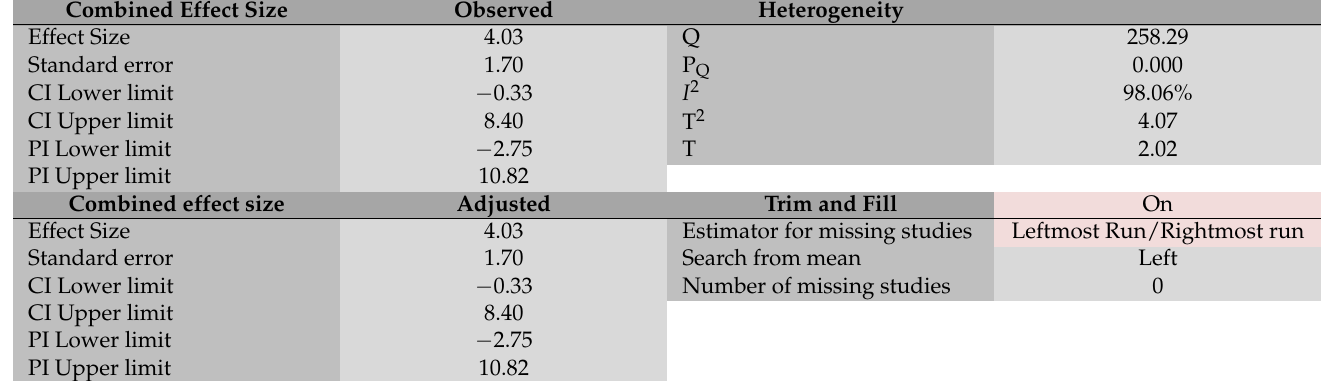
Table 5. Publication bias analysis confirming effect sizes and I 2 values.